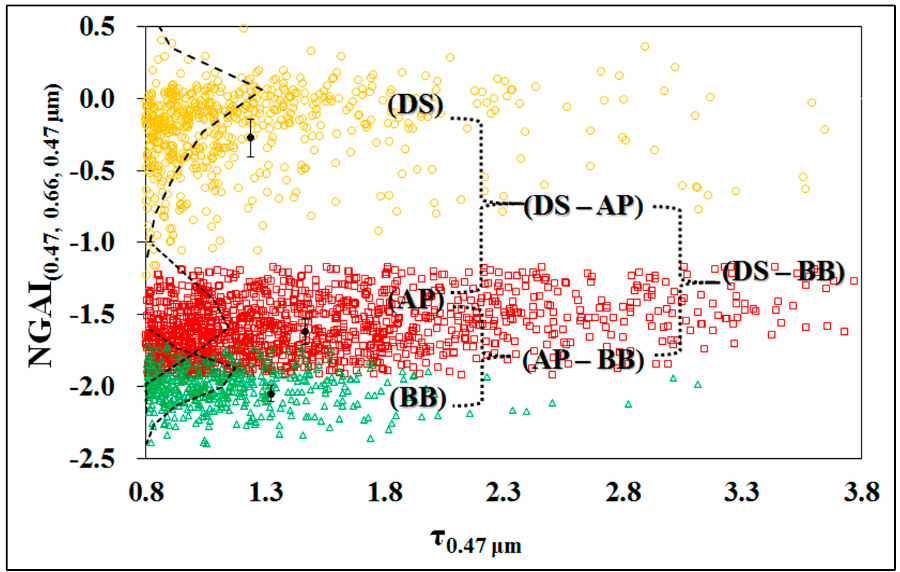
Figure A1. Scatter plots of Normalized Gradient Aerosol Index (NGAI) based on spectral AODs from ground-based measurements for the identification of aerosol type and the dual type mixtures. The dynamic ranges of NGAI 0.47dy are − 0.27 ± 0.26, − 1.62 ± 0.18, − 2.05 ± 0.11 for DS, AP and BB aerosols, respectively.